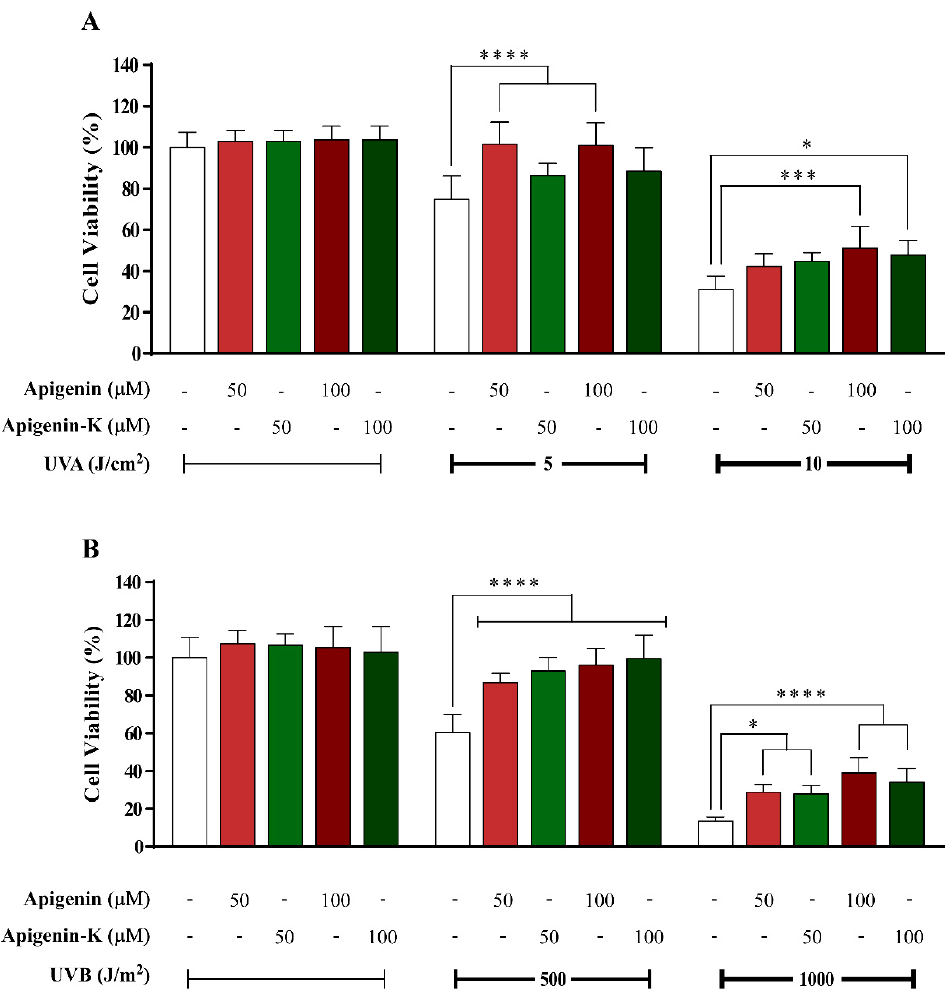
Figure 1. Human keratinocyte survival after irradiation with a 5 J / cm 2 or 10 J / cm 2 dose of UVA ( A ) or 500 J / m 2 or 1000 J / m 2 dose of UVB ( B ), in the presence of apigenin or apigenin-K (50 or 100 µ M), was determined using the MTT assay after the incubation of cells for 72 h post-irradiation. The data are expressed as the means of 6 replicates ± SDs. * p < 0.05, *** p < 0.001 and **** p < 0.0001 indicate statistically significant differences compared with the irradiated sample in the absence of compound.